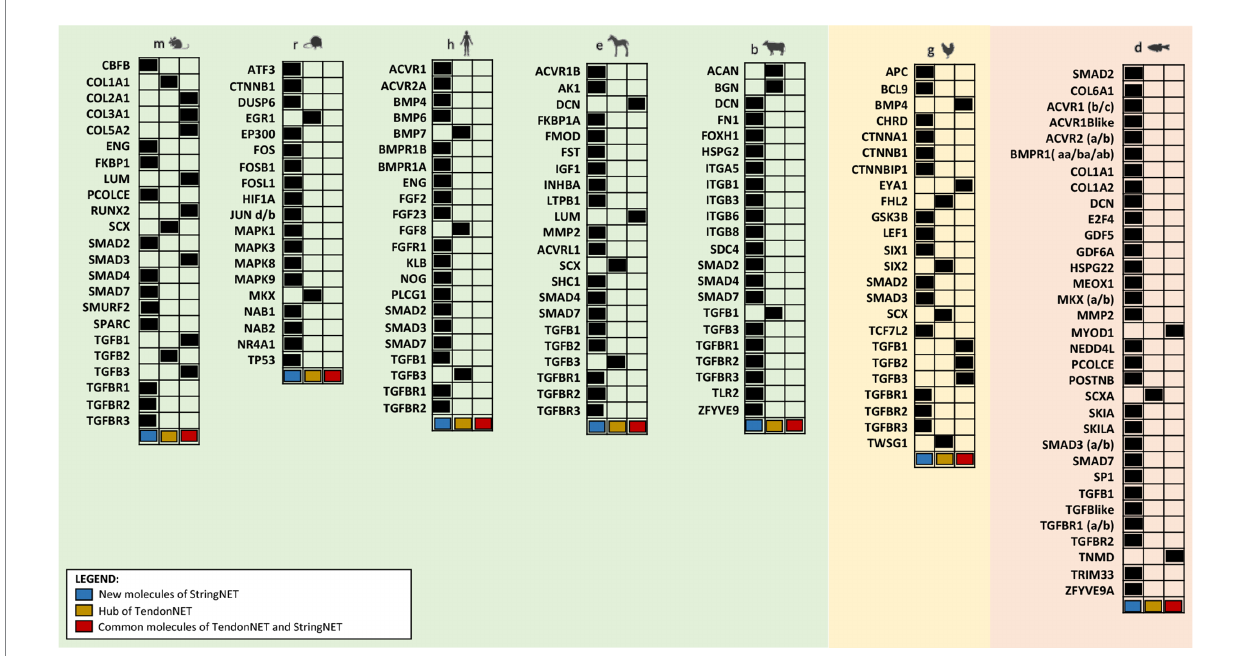
FIGURE 7 Overview of nodes composing StringNETs. StringNETs were obtained using the STRING tool (https://string-db.org/) with the hubs of the TendonNETs as input except for b where the few nodes identified in TendonNET were used. The classification presented in the figure was aimed to distinguish inside each model organism the hub molecules of TendonNETs (in yellow), the StringNETs enriched nodes (in light blue), and the common nodes between TendonNETs and StringNETs (in